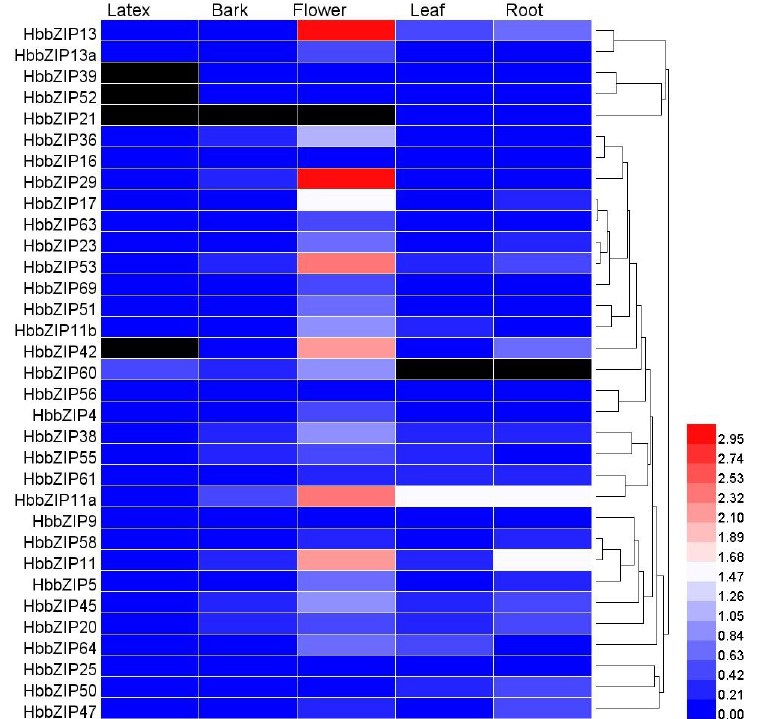
Figure 4. Expression of 33 HbbZIPs in different tissues in rubber trees.